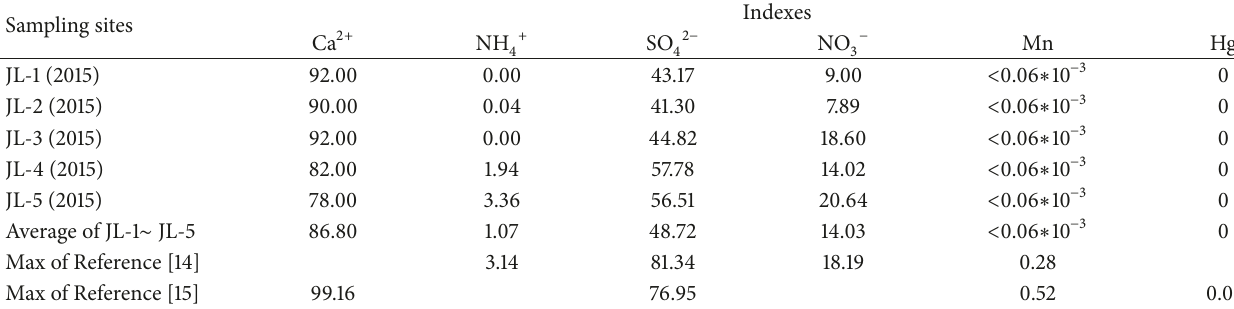
Table 2: Comparison of the main indexes in the Jila subterranean river basin (mg.L − 1).